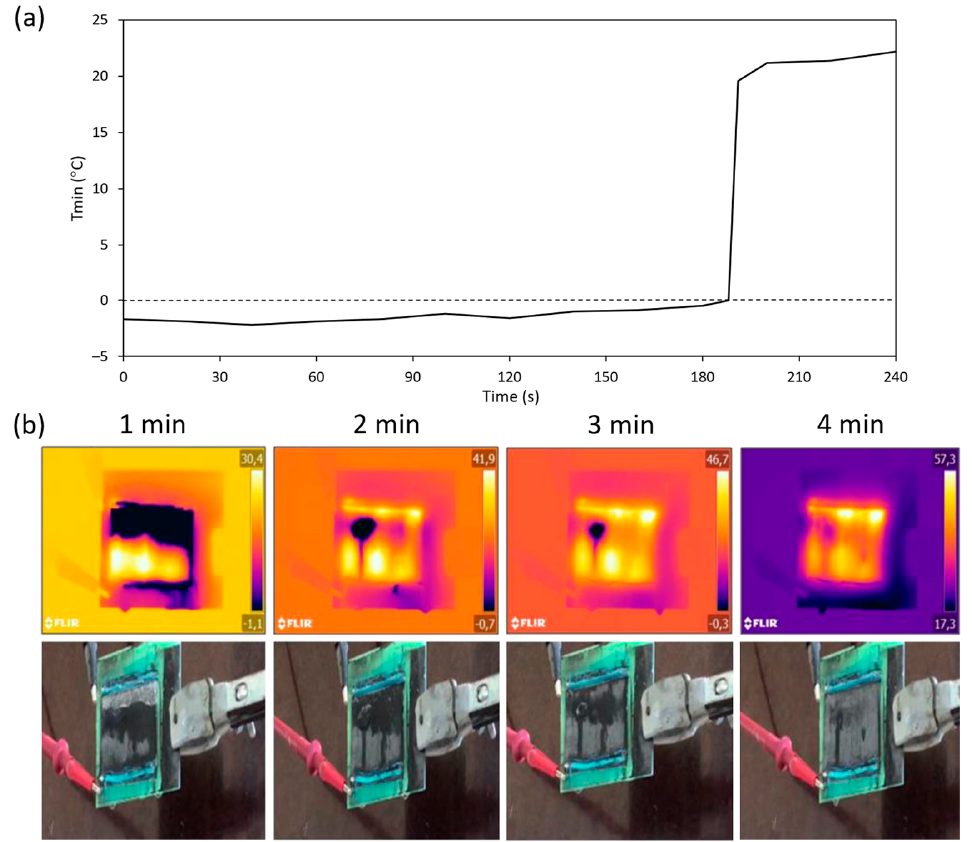
Figure 3. De-icing test of the specimen with better Joule’s heating capability (1.0% CNT + 0.5% GNP). ( a ) Minimum temperature as a function of time, and ( b ) IR thermographs and real pictures of the specimen at different times: 1, 2, 3, and 4